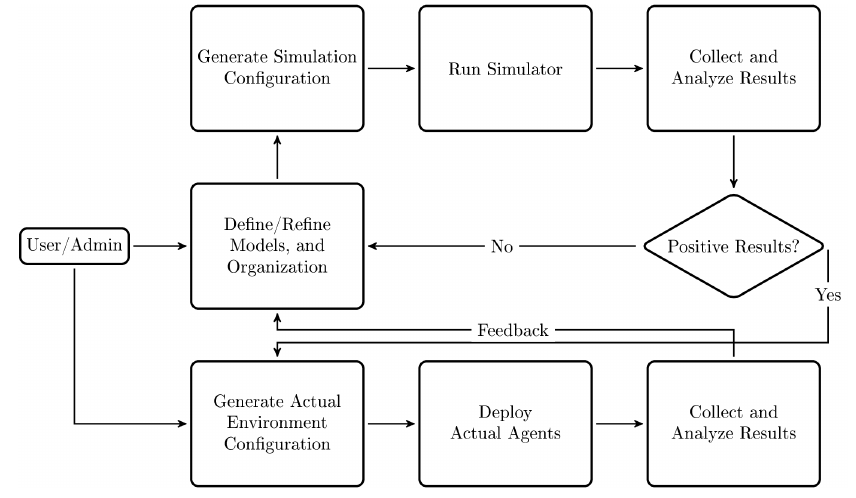
Figure 1. Workflow for MAS conception, evaluation, and